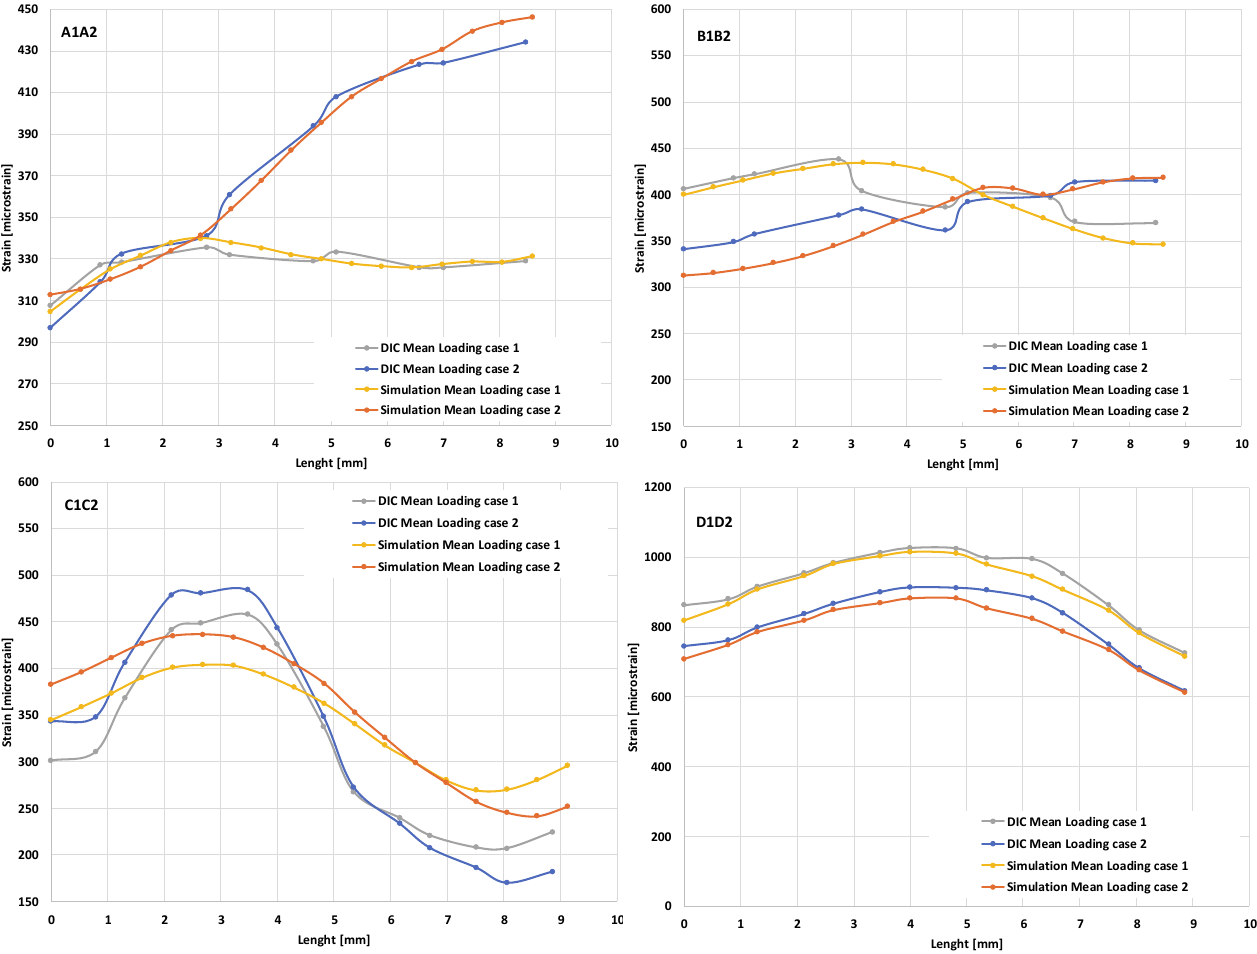
Figure 11: Maximum principal strain comparison between DIC (mean values for the 2 tests) and FEA